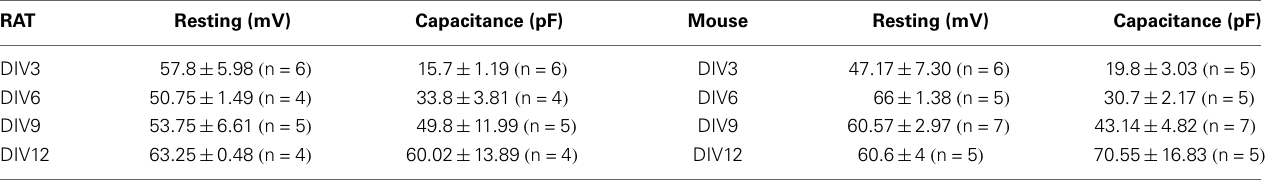
Table 1 | Electrophysiological neuronal maturation.